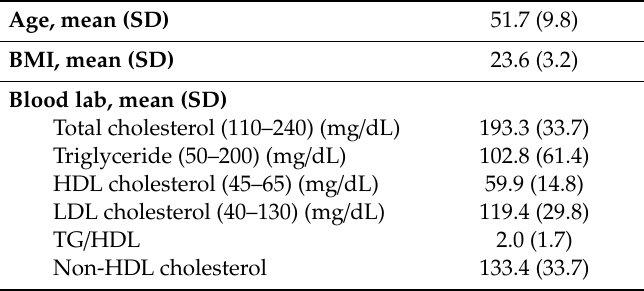
Table 1. Patients